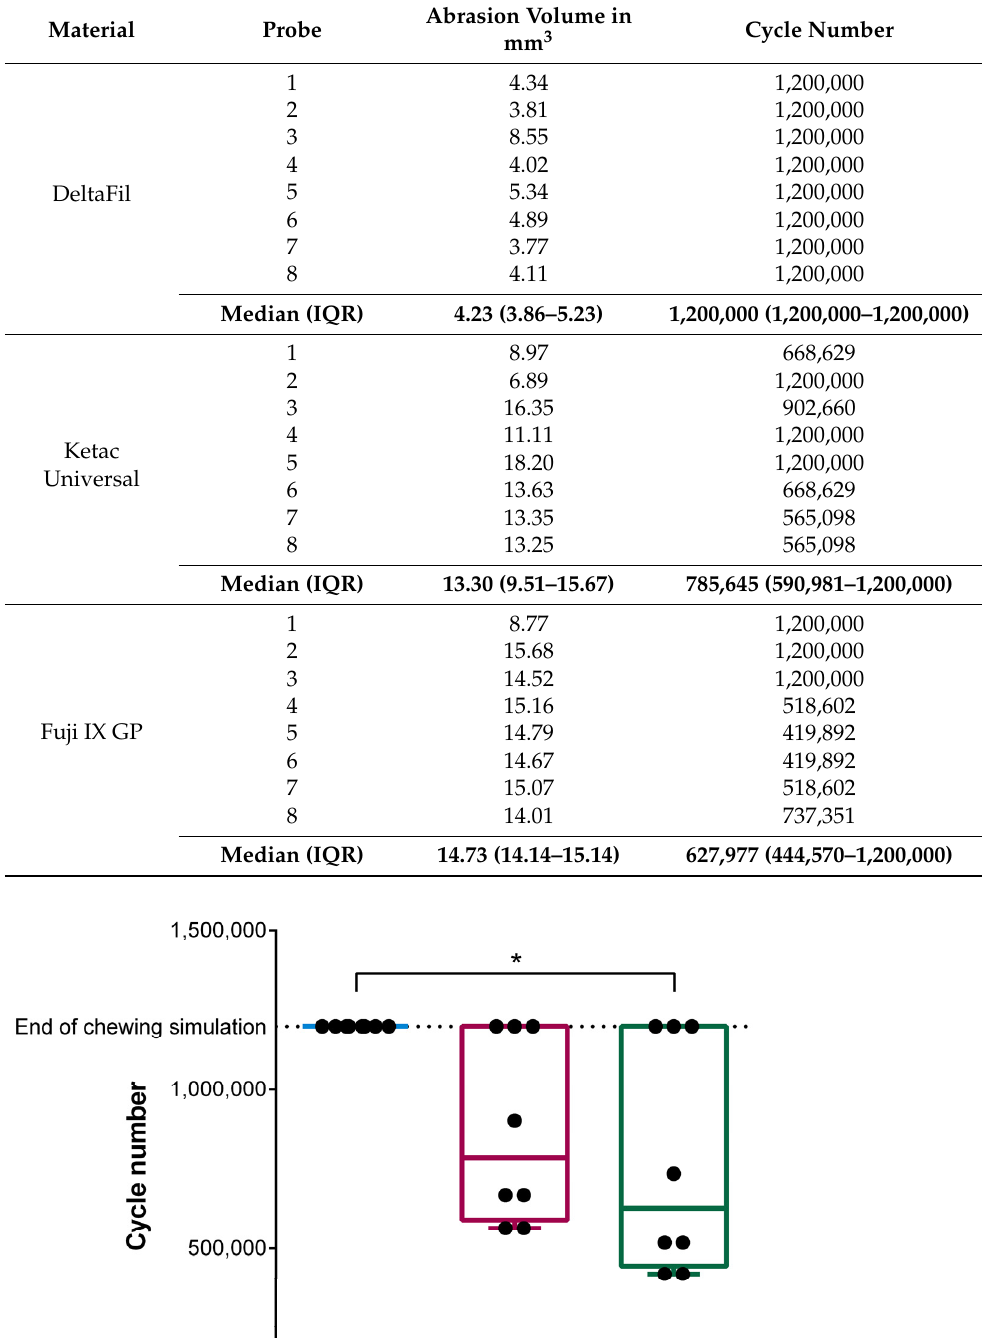
Table 2. Abrasion volume and cycle number of the restored teeth at the termination of the chewing simulation.